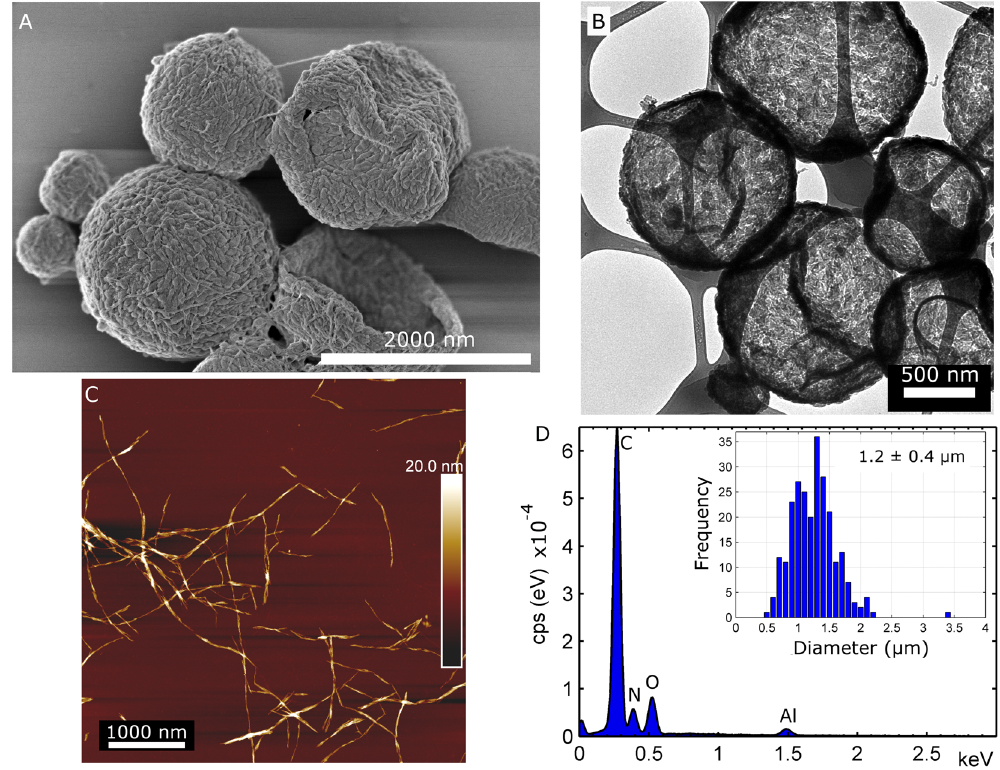
Figure 1. The oil-filled precursor capsules made from toluene diisocyanate, nanocellulose and hexadecane (oil). ( A ) High-resolution SEM image of the precursor capsules. The outer capsule wall has a rough morphology and the presence of nanocellulose is evident. ( B ) TEM micrograph of precursor capsules, demonstrating a hollow core of collapsed capsules. ( C ) AFM image of the nanocellulose used in capsule wall formation. The nanocellulose is a blend of cellulose nanocrystals (CNC) and short cellulose nanofibers (CNF). ( D ) EDS spectrum of precursor capsules. Inset: The size-distribution of the capsules diameters, the average diameter is 1.2 ± 0.4 µ